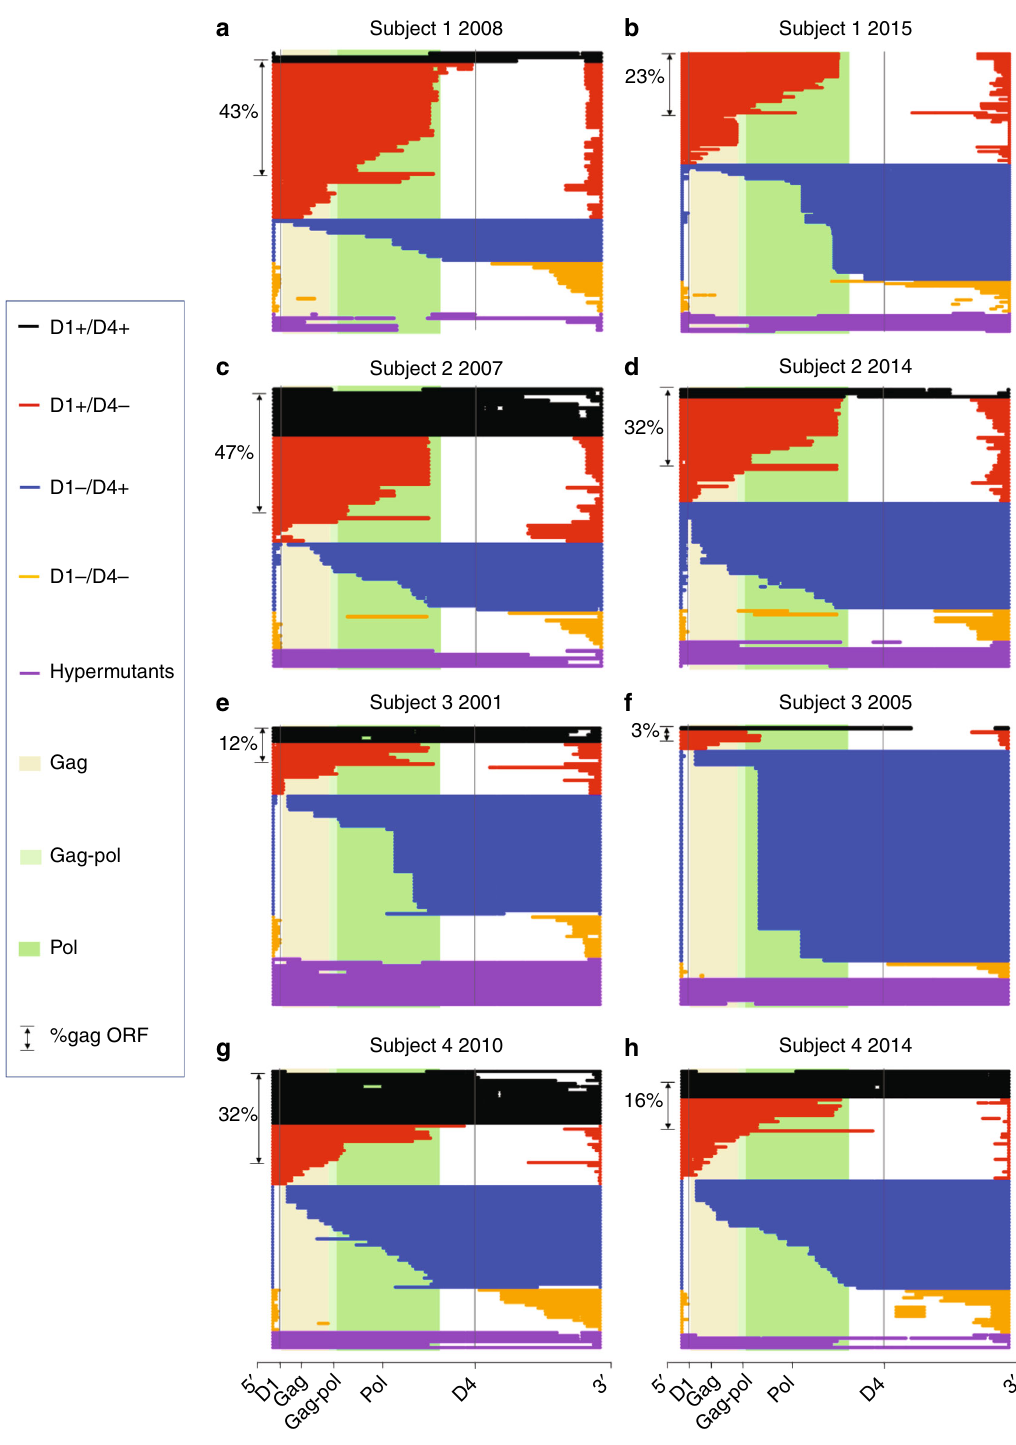
Fig. 4 Deletion analysis reveals a role for splicing in reservoir dynamics. a Defective proviruses from an apheresis sample collected from Subject 1 in 2008 (~1 year of ART) are aligned to HXB2. In order, from top to bottom, black proviruses are D1 + D4 + , red proviruses are D1 + D4 − , blue proviruses are D1 − D4 + , and gold proviruses are D1 − D4-. Hypermutated proviruses are represented in purple. The shaded beige, light green, and dark green regions correspond to the gag, gag-pol, and pol regions of HXB2, respectively. On the left side of panels a – h we show the percentage of defective proviruses containing a complete Gag ORF. b Defective proviruses from Subject 1 for the apheresis sample collected in 2015 (~8 years of ART). Proviruses are graphed on the same scale to demonstrate how the proportion of each type of defective proviruses changed from fi rst to last time point. c , d Defective proviruses from Subject 2 for the apheresis sample collected in 2007 (~2 years of ART) and in 2014 (~9 years of ART). e , f Defective proviruses from Subject 3 for the apheresis sample collected in 2001 (~4 years of ART) and in 2005 (~9 years of ART). g , h Defective proviruses from Subject 4 for the apheresis sample collected in 2010 (~2 years of ART) and in 2014 (~7 years of ART). The time points used for the deletion maps are identi fi ed by asterisks in Fig. 1. The fi rst black provirus depicted in a contains a D1 and terminates within the gag ORF, but this is obscured due to imperfect R-coded fi ltering